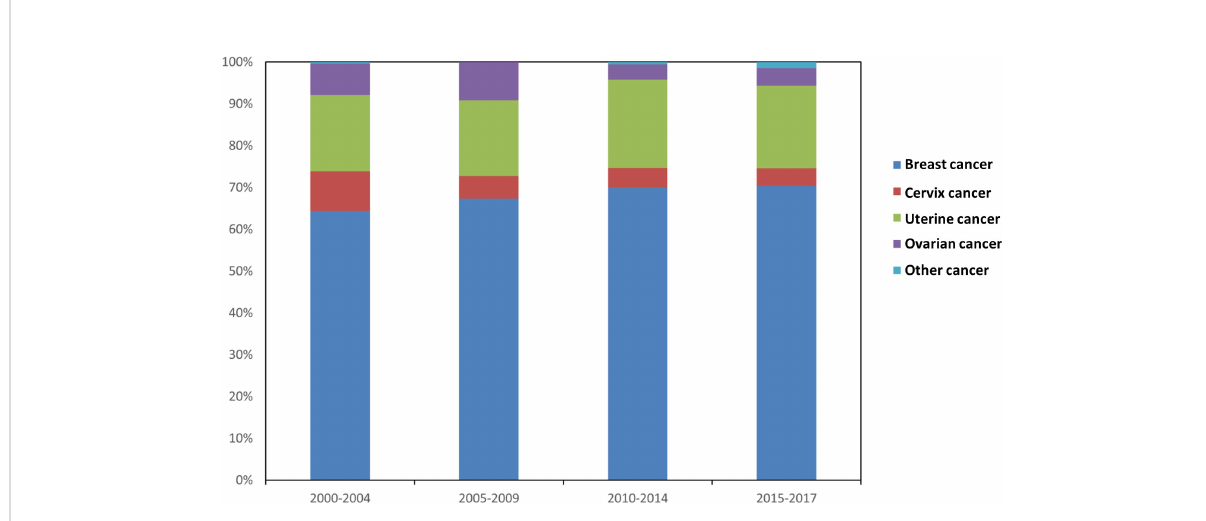
FIGURE 1 Relative frequency of suicide cases among survivors with different types of female-speci fi c cancer diagnosed from 2000 to 2017.